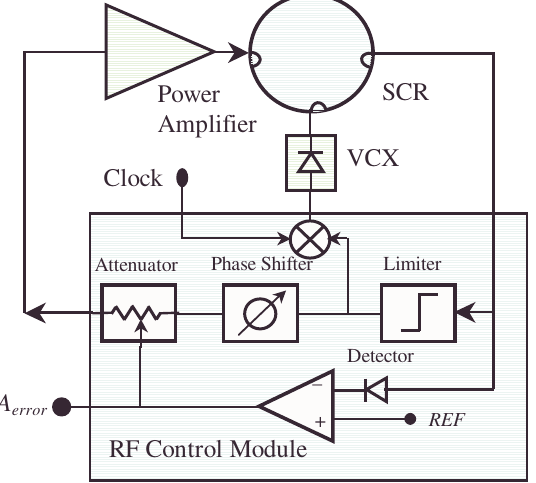
FIG. 3. (Color) Simplified rf diagram of the ATLAS super- conducting resonator in accelerating mode.